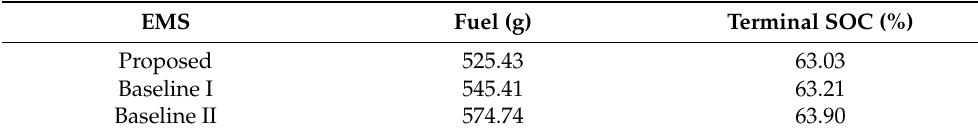
Figure 7. Trajectories of fuel consumption (a) and battery SOC (b) using different strategies in training conditions. Table 5. Comparison among various EMSs in the training condition.